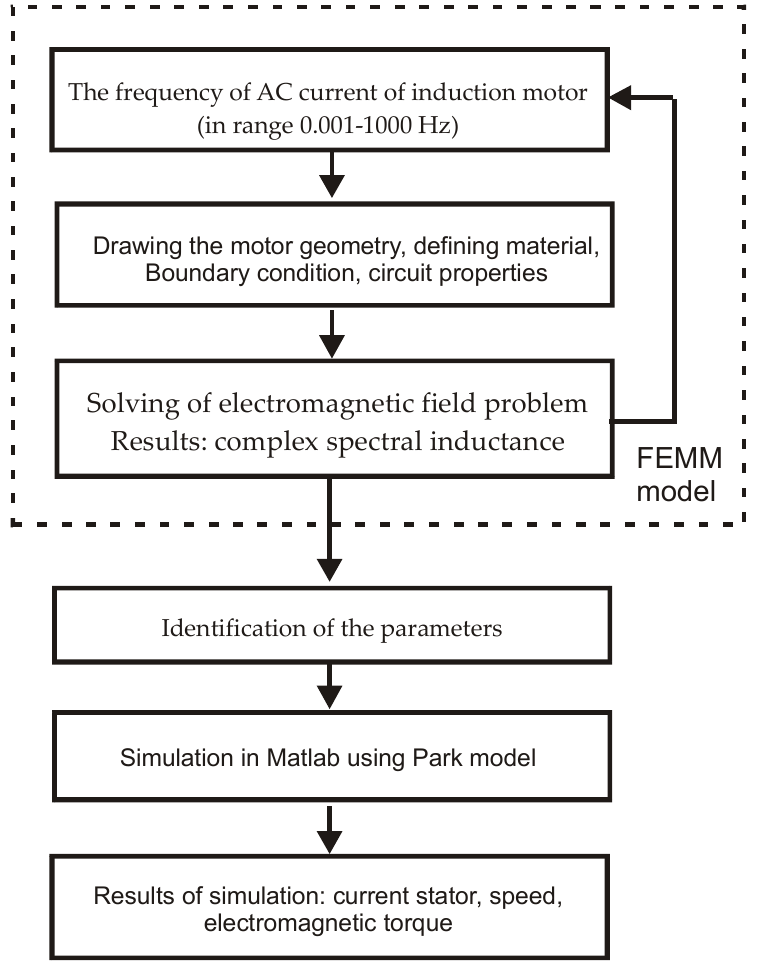
Figure 12. Flowchart of calculation process.